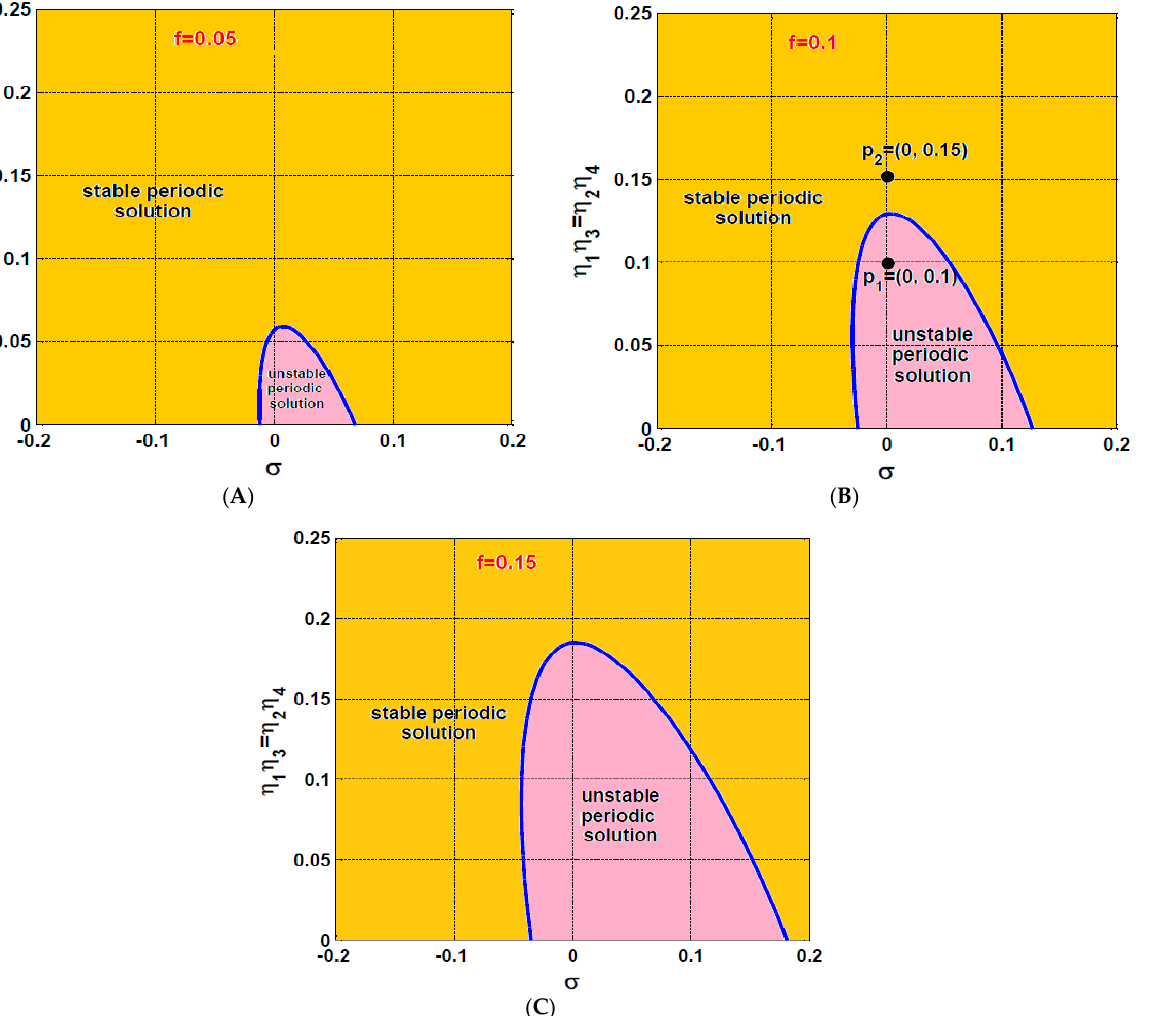
Figure 21. Stability chart of the rotor system in 𝜎 − 𝜂 1 𝜂 3 = 𝜂 2 𝜂 4 plane at three different values of 𝑓 :